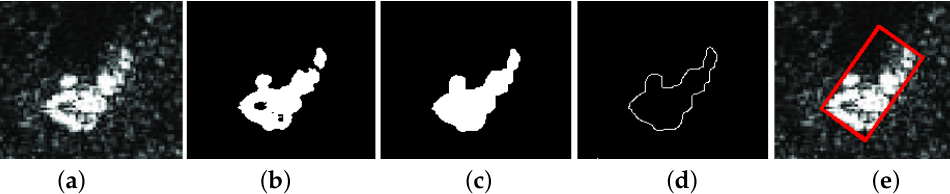
Figure 12. The stages of post-processing: ( a ) bounding box of object detected by YOLO network; ( b ) the result of Otsu segmentation; ( c ) the result of morphological closing; ( d ) the result of applying Canny edge detector; ( e ) minimal area bounding